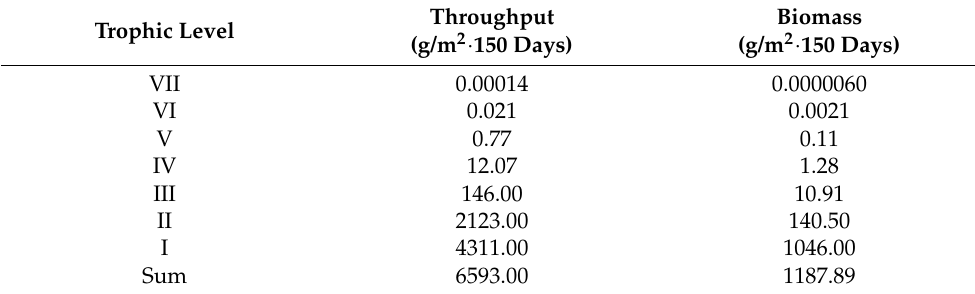
Figure 3. Proportion of energy throughput consumption.